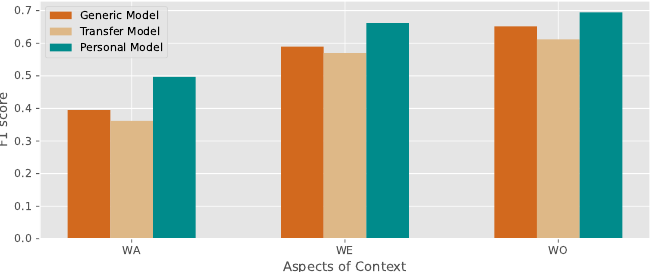
Figure 2. Comparison of the performance of the generic model, personal model, and transfer model.